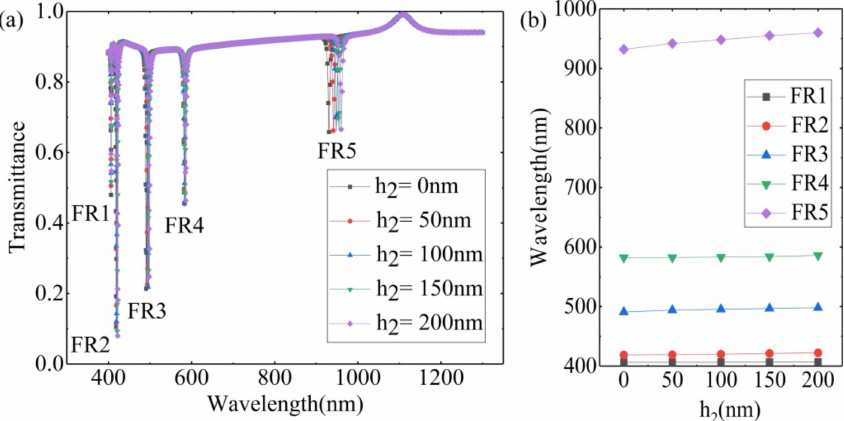
Figure 8. ( a ) The transmittance spectra for different h 2 ; ( b ) the resonance wavelength of FR1, FR2, FR3, FR4 and FR5 with different h 2 .